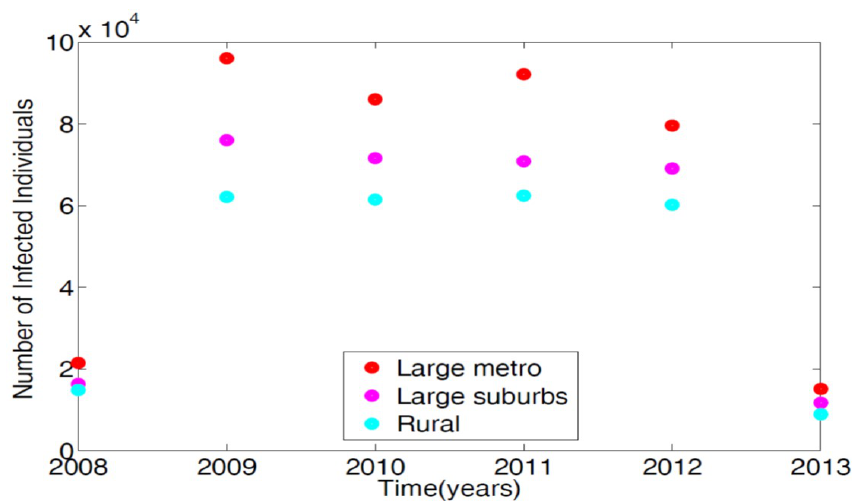
Figure 2. Demographic data from three regional areas, large metro, large suburb, and rural. Large metropolitan data gives the highest number of MRSA patients discharged with MRSA ICD-9 code listed on their medical record in the magnitude of tens of thousands.